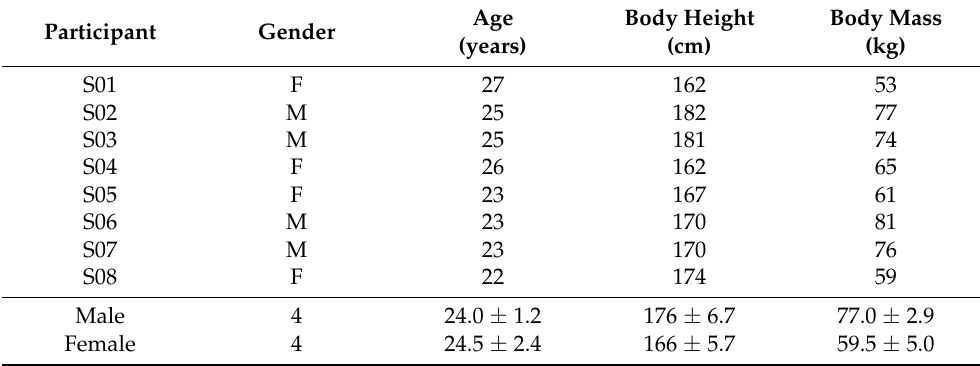
Table 1. Participants’ anthropometric data and mean ( ± standard-deviation) regarding